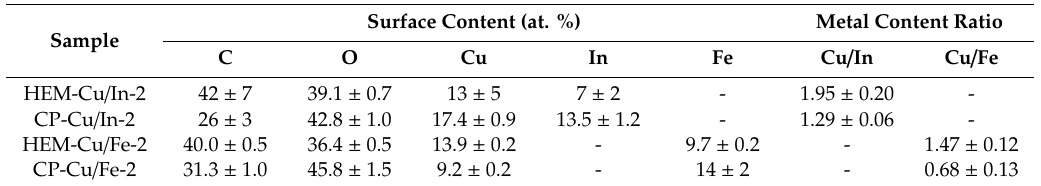
Table 2. Surface composition in mixed oxide samples determined by XPS. Atomic percentages are reported as mean values ± 1S (values averaged out of at least three replicates). Surface Content (at. %) Sample